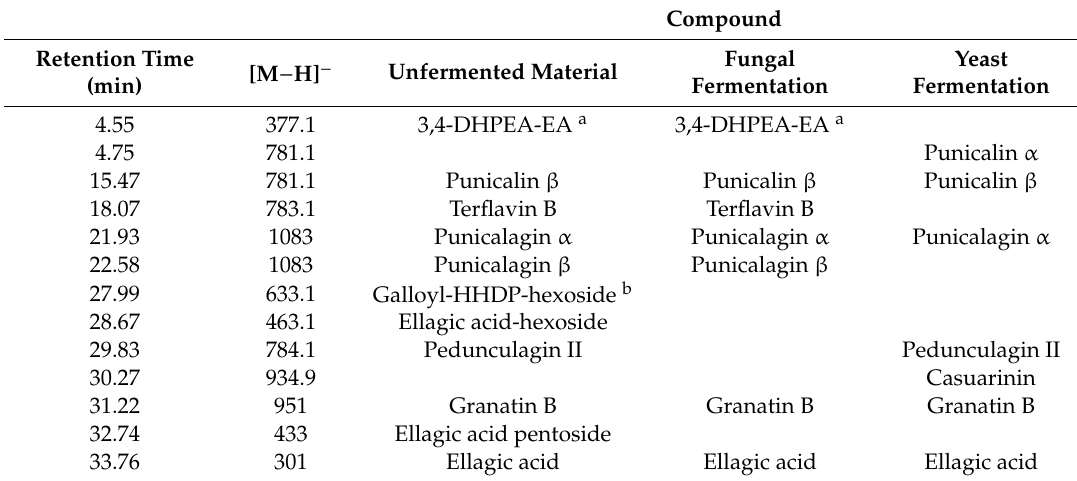
Table 1. Identification of ellagitannin-related compounds in the extracts of unfermented / fermented pomegranate husks powder by LC / MS